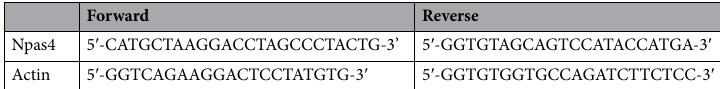
Table 1. Oligonucleotide sequences for real-time PCR